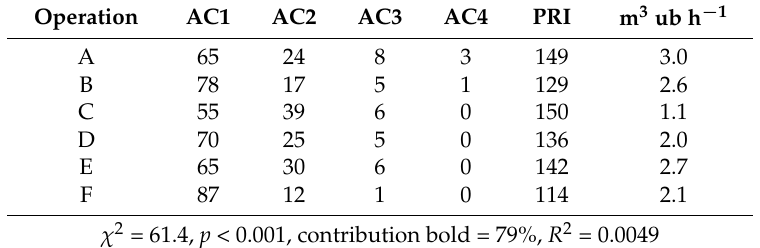
Table 3. Percent distribution of observed frames among postural risk classes, by operation ( n = 1200).